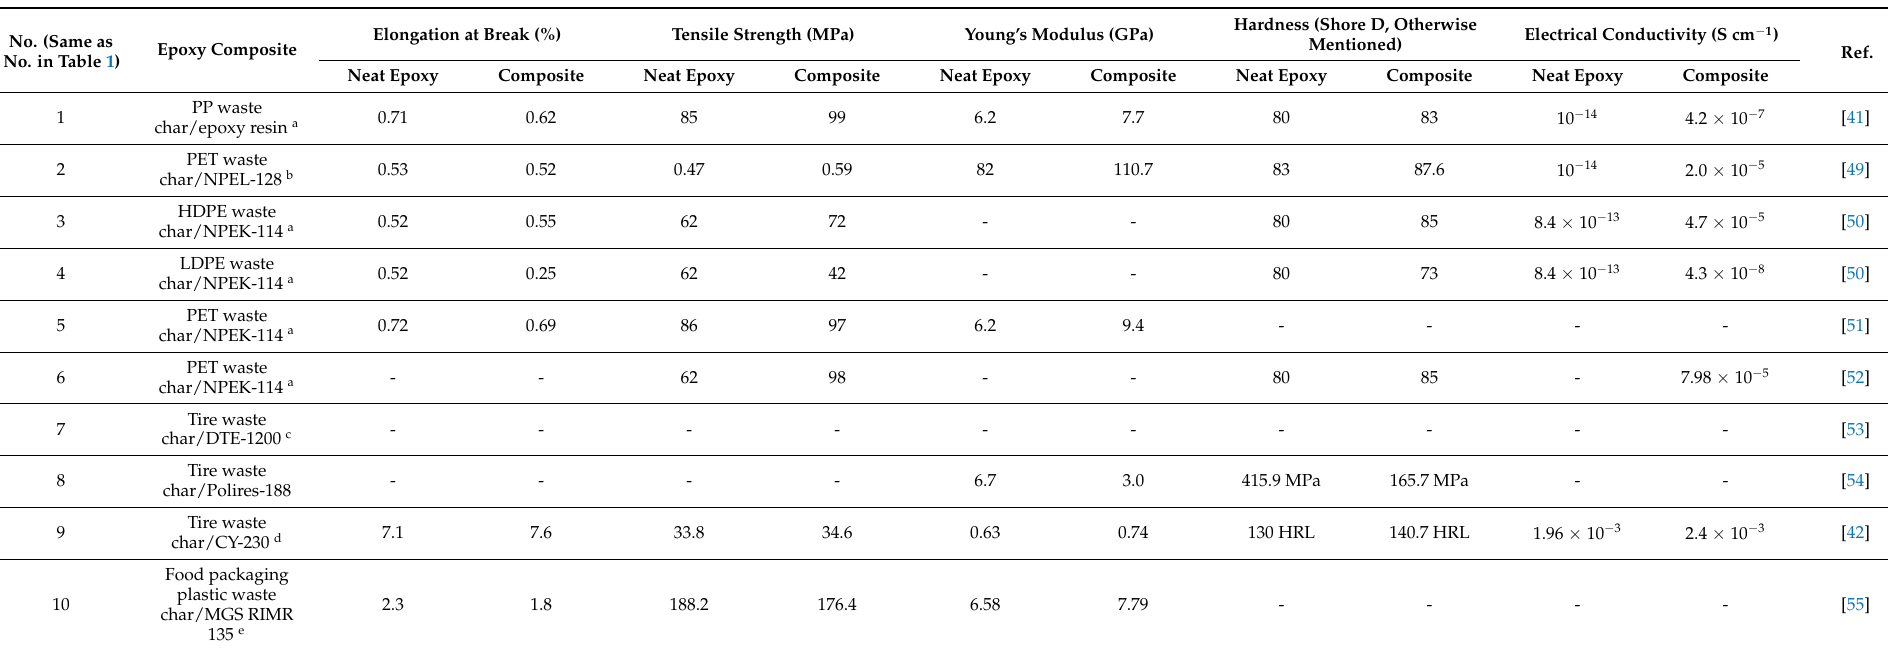
Table 3. Comparing representative characteristics of neat epoxy and epoxy composites made from epoxy resin and plastic-waste-derived